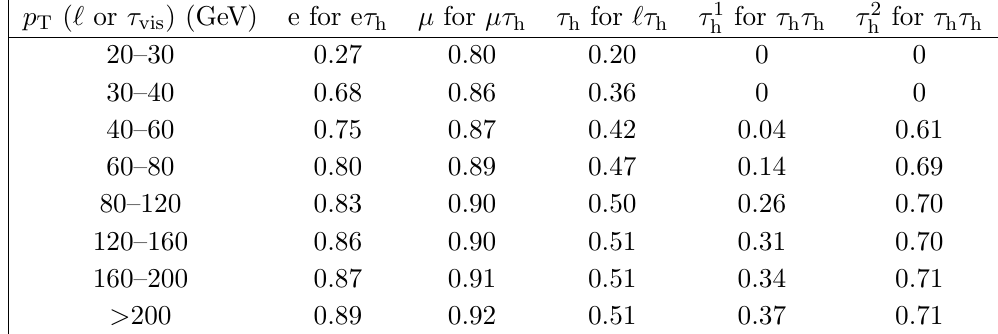
Table 8 . E(cid:14)ciencies to select a lepton or (cid:28) and subleading (in p T ) (cid:28) h in the (cid:28) h (cid:28) h channel. Zero for the e(cid:14)ciency shows the region where the generated (cid:28) leptons do not pass the kinematical and geometrical selection cuts.